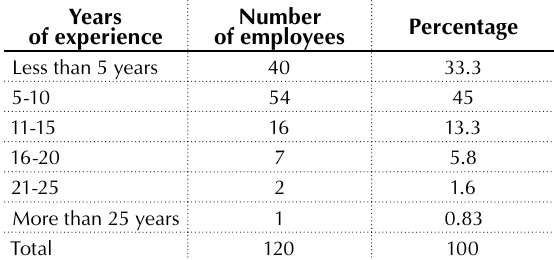
Table 5. Frequency distribution of the study sample according to their experience